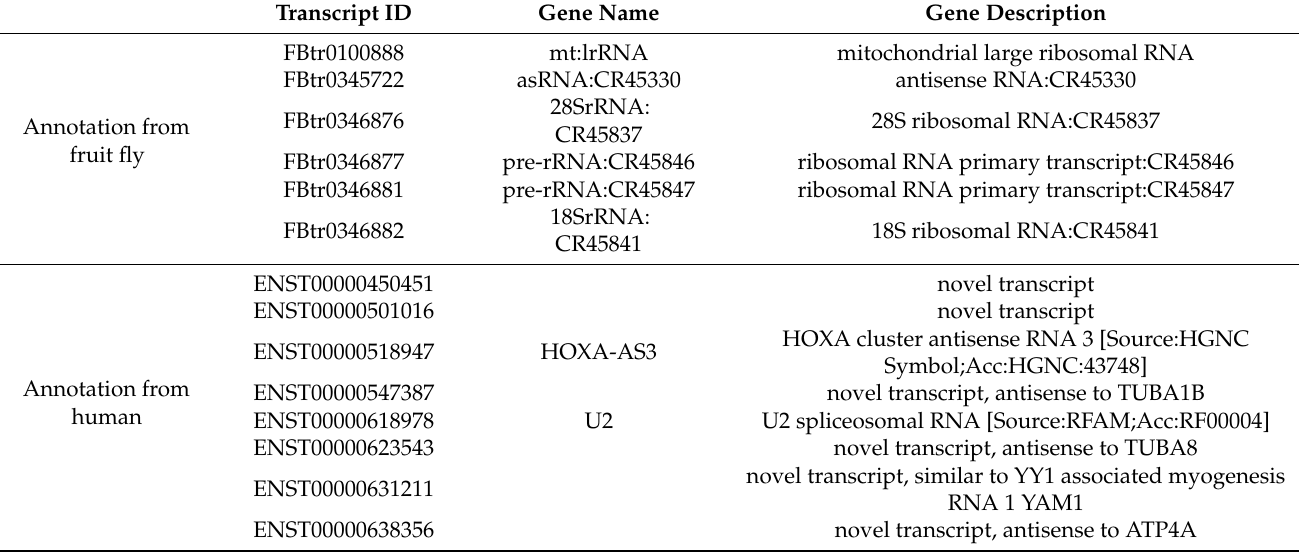
Table 6. ncRNA transcripts expressed both in E. okinawaensis and B. mori .